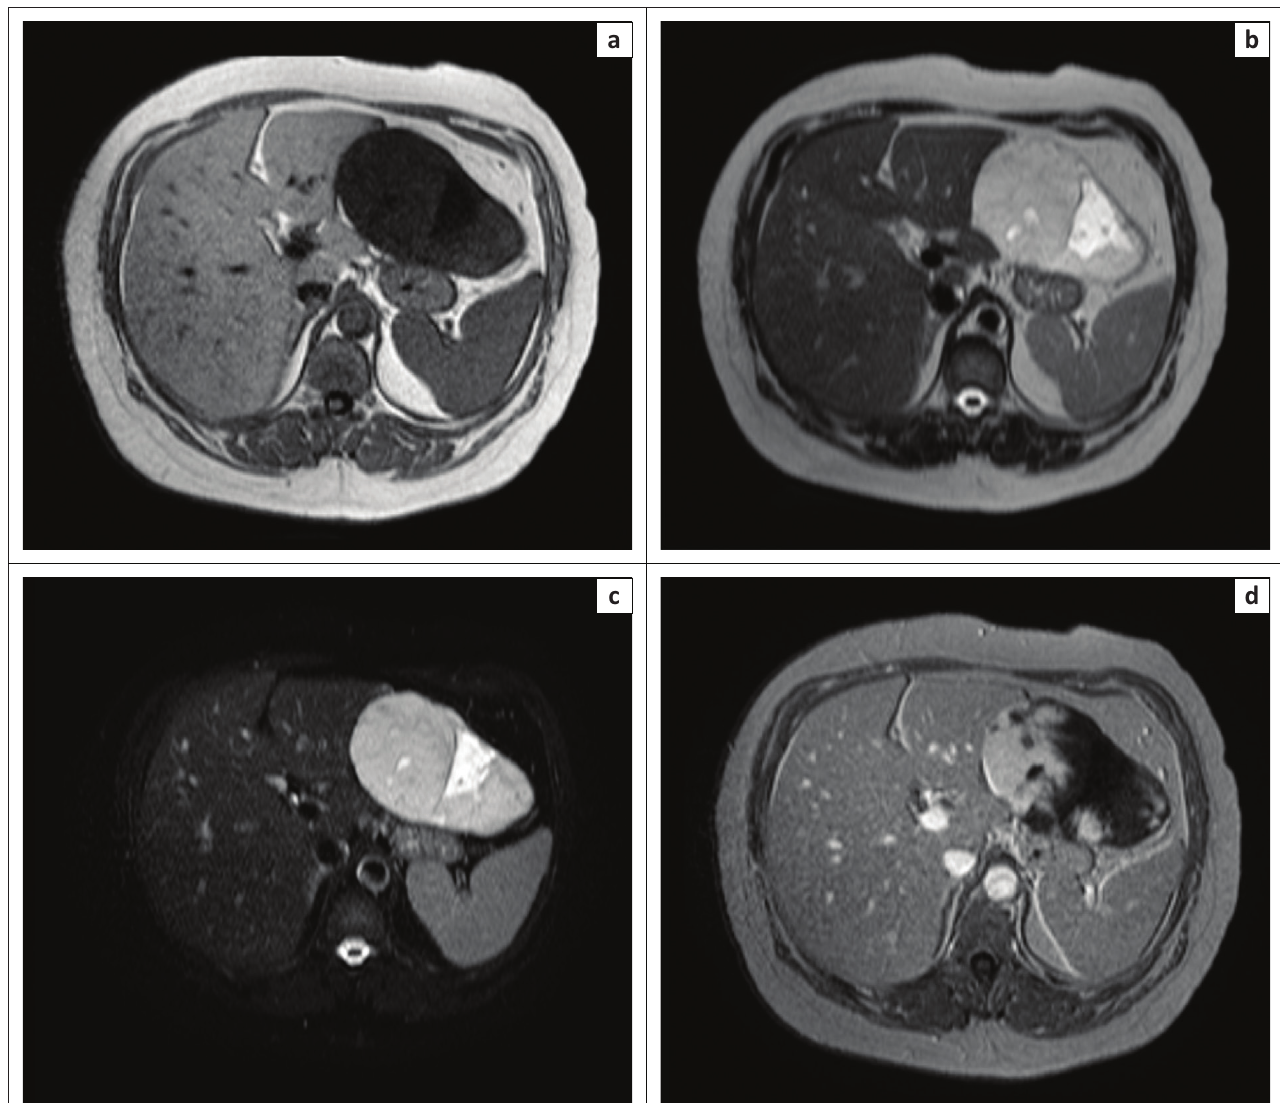
FIGURE 4: T1W image (a) reveals the mass to be hypointense with a cleft-like area of lower signal intensity within. The mass is brightly hyperintense on T2W (b) and SPAIR (c) suggestive of a light bulb sign with a cleft-like area of marked high signal intensity within signifying a hepatic haemangioma. Post-contrast scan (d) shows patchy peripheral enhancement. Dynamic contrast-enhanced scan (not shown) revealed centripetal enhancement with contrast from the arterial through the delayed